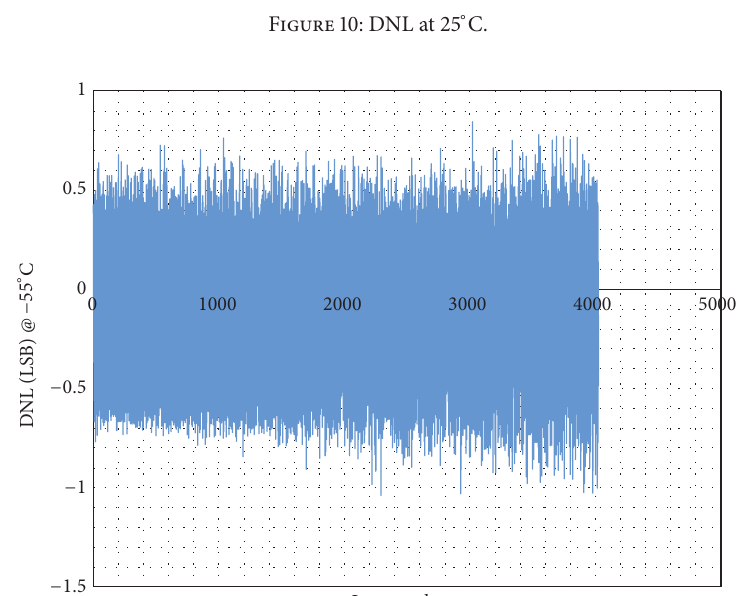
Figure 10: DNL at 25 ∘ C.